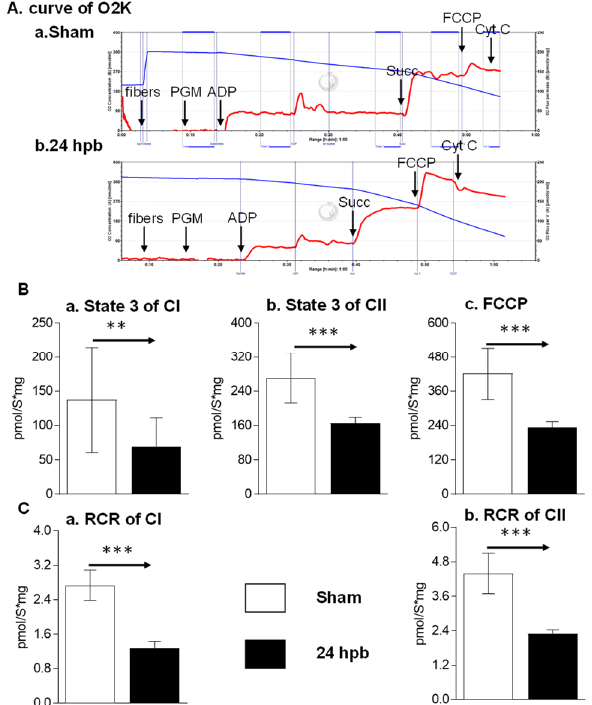
Figure 1. Cardiac mitochondrial respiration in the sham ( n = 9) and burn groups ( n = 9): ( A ) original mitochondrial respiration curve, PGM: pyruvate, glutamate and malate; ADP, Adenosine diphosphate; Succ: succinate; FCCP, protonophore carbonyl cyanide p-trifluoromethoxy-phenylhydrazone; Cyt C, cytochrome c. Oxygen concentration ([ µ M] blue line) and oxygen flux per tissue mass (pmol · s − 1 · mg − 1 wet weight) (red line) are displayed. Black arrows showed when the substrates / reagents were injected. ( B ) electron flow was supported with complex I ( a ), complex II ( b ), and the uncoupling agent ( c ); ( C ) respiratory control ratios (RCRs) energized by complex I substrate ( a ) and complex II substrate ( b ) were calculated as the ratios between state 3 and state 4 rates. Data are triplicated ( n = 9) and plotted as the mean ± SD. Significance is denoted as follows: ** ( p < 0.01), *** ( p < 0.001).